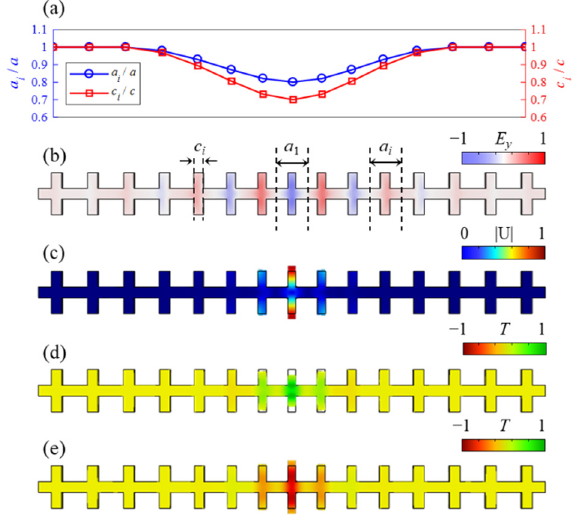
Table 1. Varied geometric parameters of the cavity cells. Note that the other geometric parameters b , w , and t of the cavity cells are all fixed.